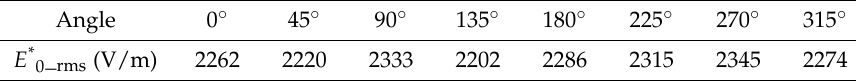
Table 6. Results of the experiment for directional characteristics of the